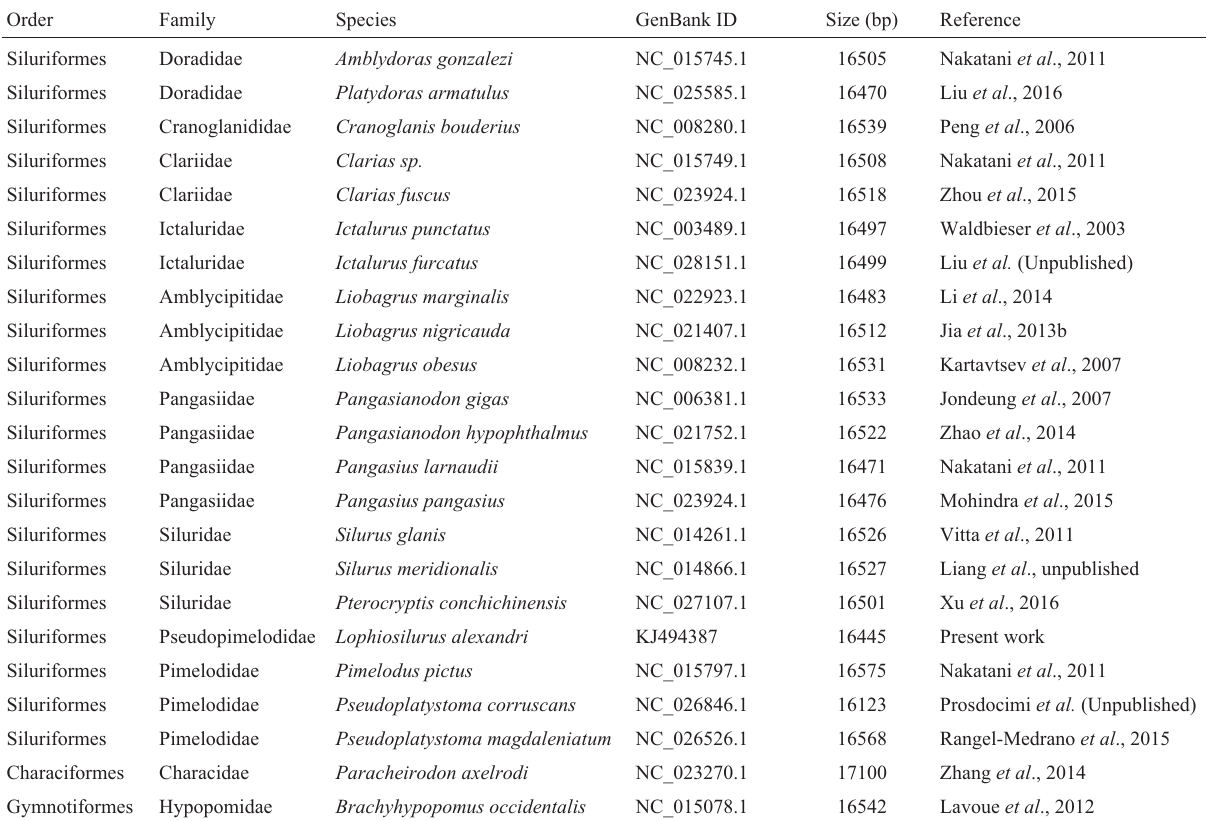
Table 1 - List of species, taxonomic information and accession numbers used in the phylogenetic